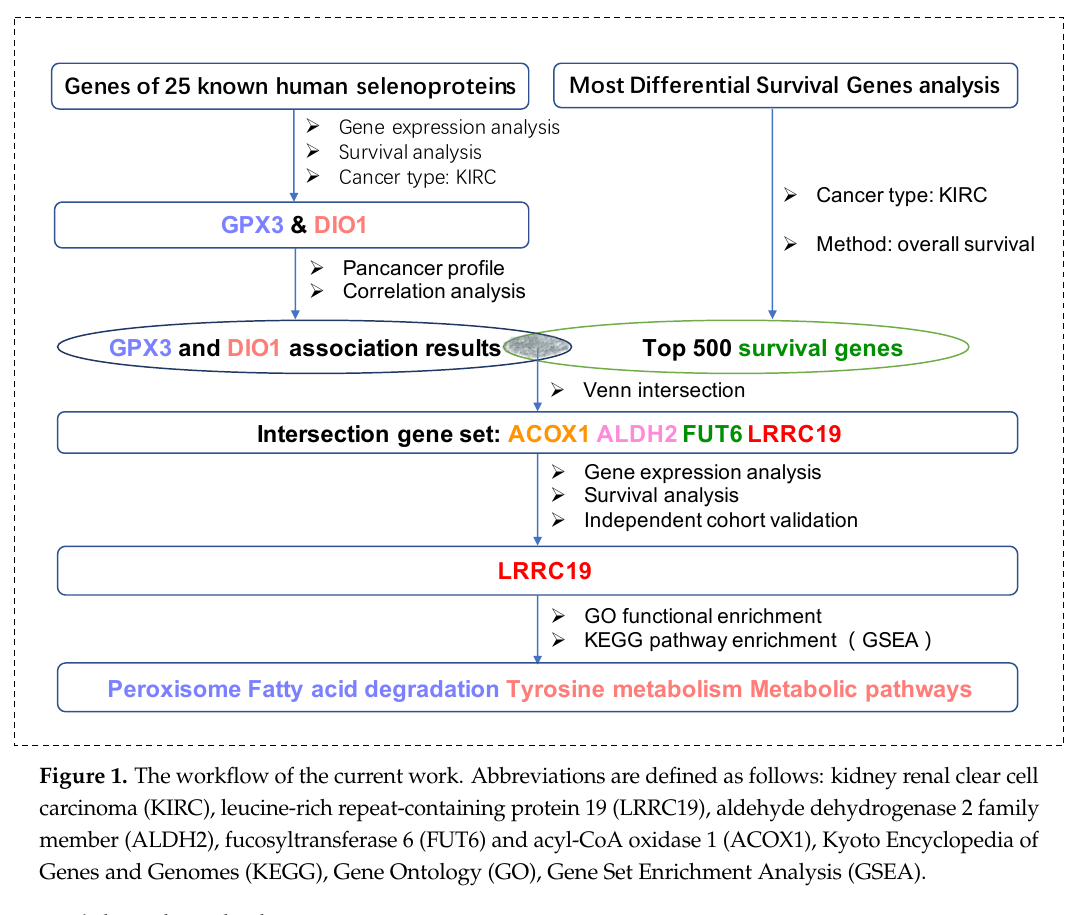
Figure 1. The workflow of the current work. Abbreviations are defined as follows: kidney renal clear cell carcinoma (KIRC), leucine-rich repeat-containing protein 19 (LRRC19), aldehyde dehydrogenase 2 family member (ALDH2), fucosyltransferase 6 (FUT6) and acyl-CoA oxidase 1 (ACOX1), Kyoto Encyclopedia of Genes and Genomes (KEGG), Gene Ontology (GO), Gene Set Enrichment Analysis